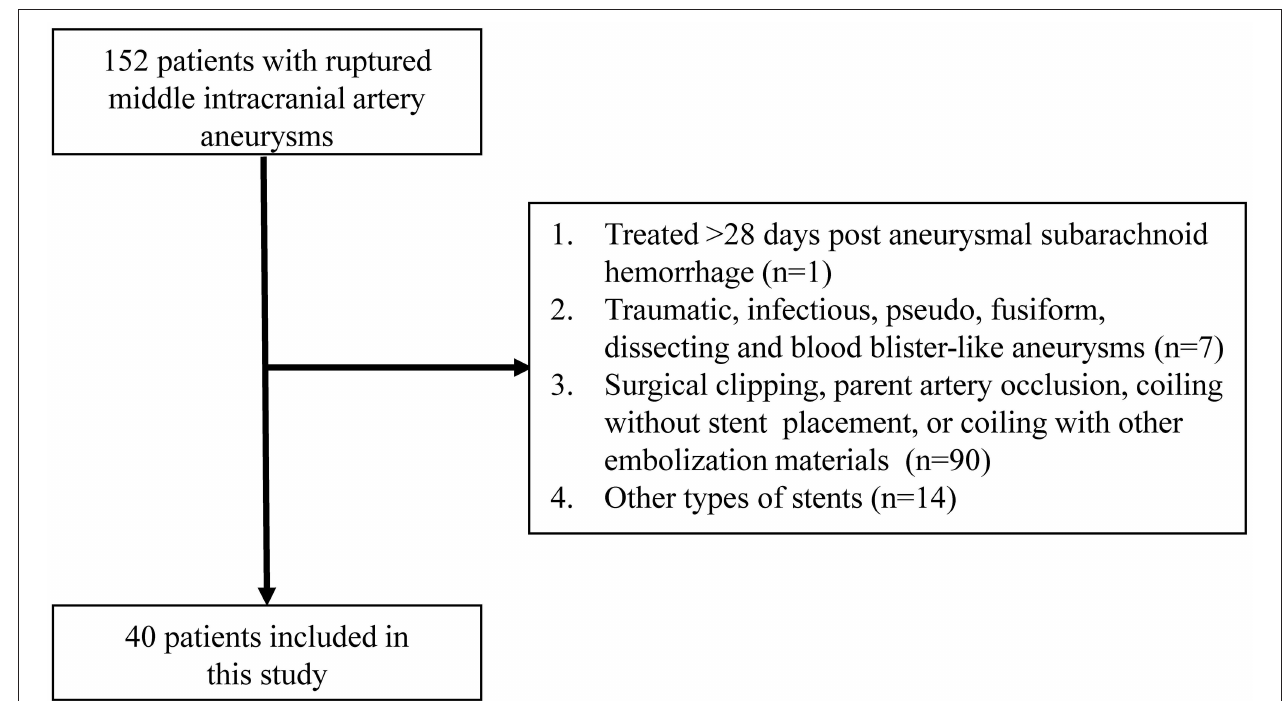
FIGURE 1 | Flow diagram of patient selection according to the inclusion and exclusion